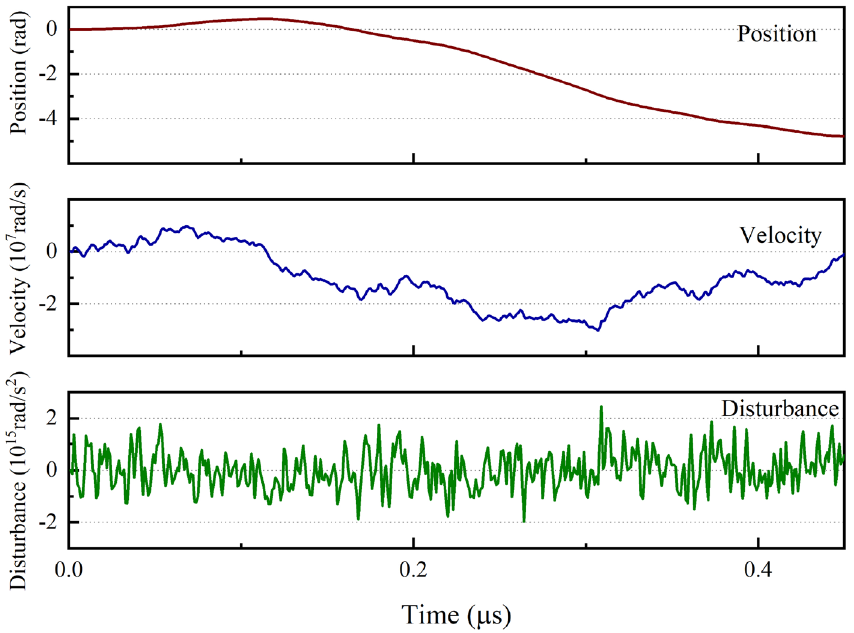
Figure 4. Time traces of the object motion signals. The position, velocity, and acceleration (disturbance) characteristics of the motions caused by random perturbations are shown by these